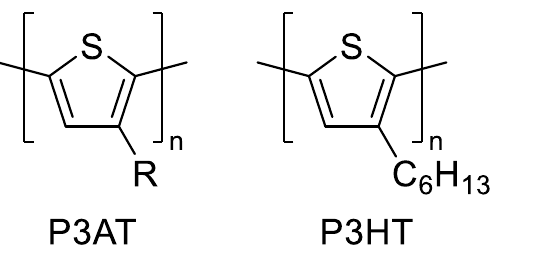
Figure 4. Left : General structure of poly(3-alkylthiophenes) (P3AT); Right : poly(3-hexylthiophene) (P3HT).